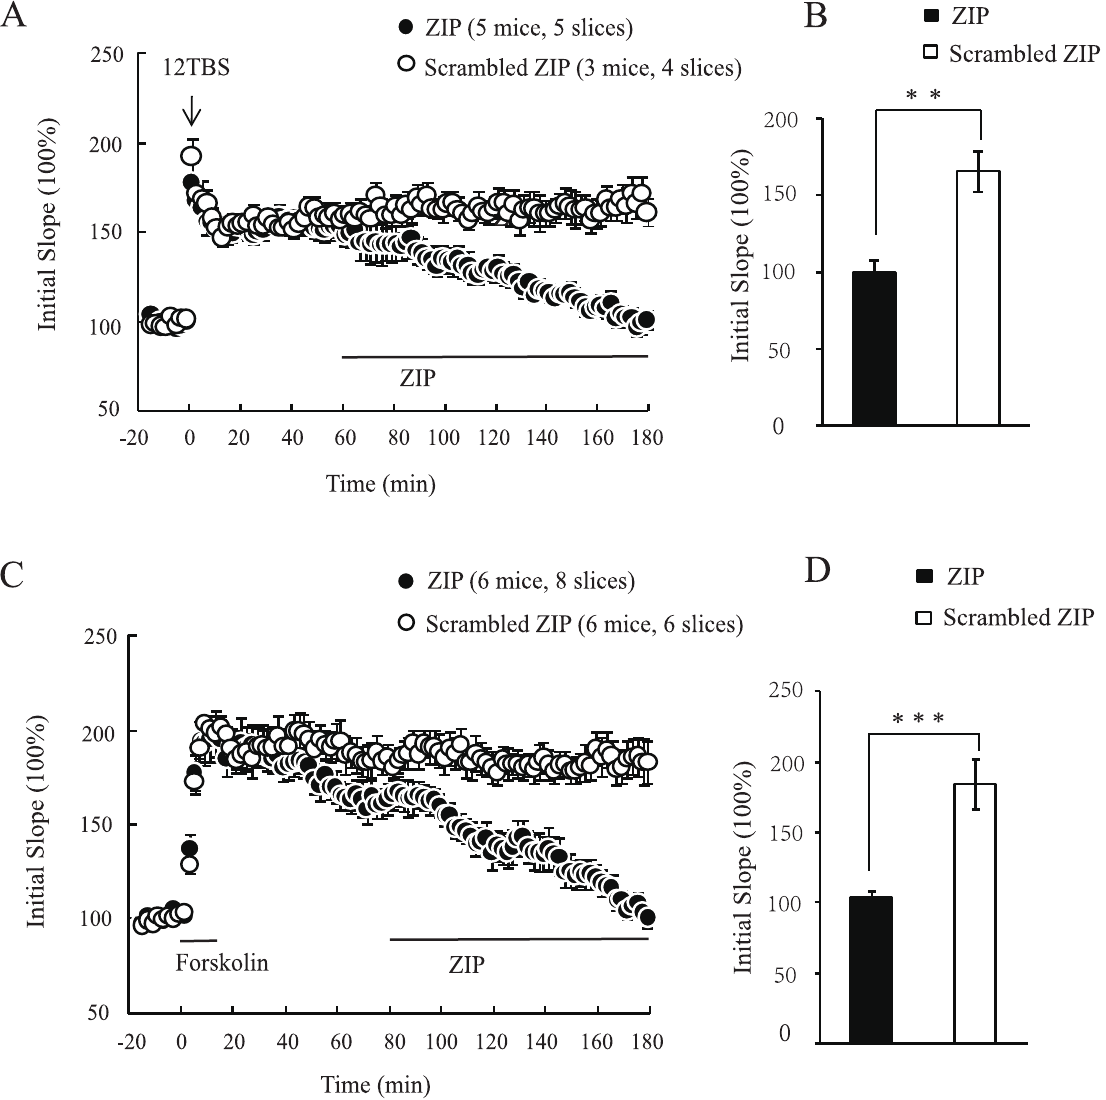
Figure 1. BDNF-dependent late phase LTP is mediated by PKM f . (A, B) 12 TBS-induced L-LTP was reversed by PKM f inhibitor ZIP. Field EPSP (fEPSP) was evoked in CA1 stratum radiatum by stimulating Schaffer Collateral in adult C57BL/6 mice. (A) After a stable baseline was obtained, 12 TBS was conducted. LTP was sustained at least for 3 hours. ZIP (5 m M) or scrambled ZIP peptide (5 m M) was applied at 1 hour after stimulation. (B) Quantification of the initial slope value from the last 5 minutes recording. (C, D) Forskolin-induced L-LTP was abolished by PKM f inhibitor ZIP. The experiments were done identically as in (A), except that L-LTP was induced by a transient perfusion of forskolin (50 m M) and IBMX (30 m M) for 15 minutes. ZIP or scrambled ZIP was applied at 80 minutes after chemical induction when stable L-LTP was fully established. Numbers of slices and mice used in each condition are indicated at the top of each plot. In this and all other figures, data are presented as mean 6 s.e.m. * p , 0.05, ** p , 0.01,*** p , 0.001, Student’s